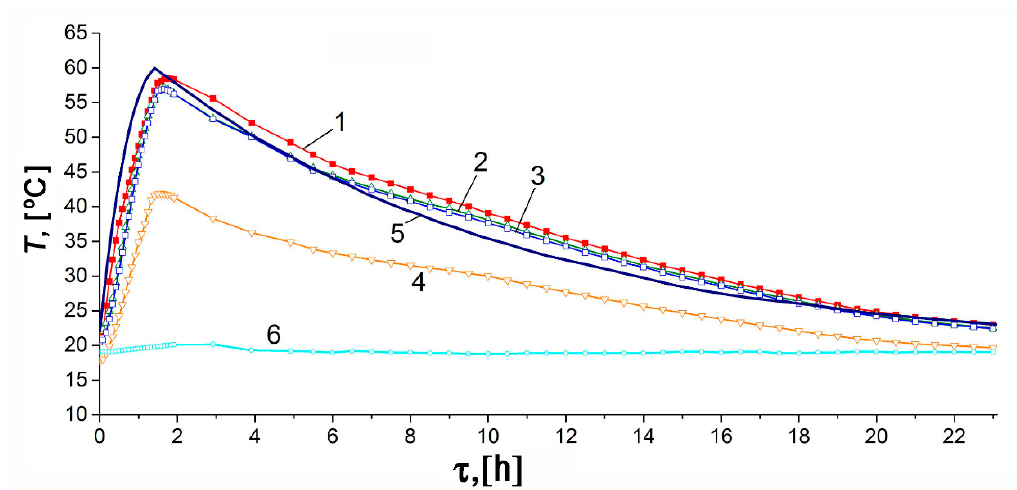
Figure 10. Temporal variations of the temperature inside (TE1) and outside the adsorber during the charge cycle under the thermally insulated conditions: curves 1–4 correspond to the TE1–4 sensors readings, respectively; curve 5 is the average adsorber temperature calculated from the model, curve 6 is the ambient temperature.